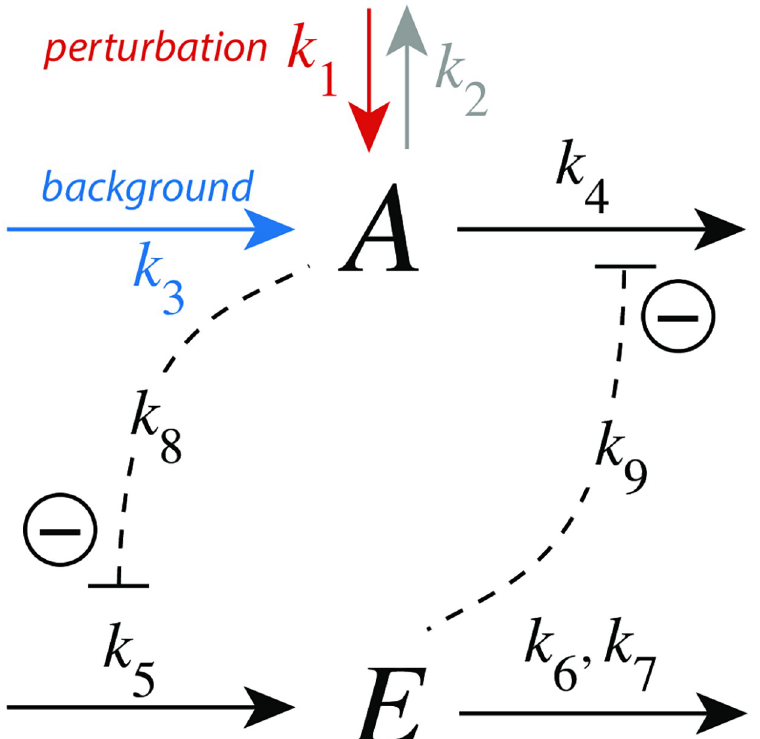
Fig 10. Outflow controller motif m8 with integral control implemented as a zero-order Michaelis-Menten (MM) type degradation of E. Rate constant k 1 undergoes a perturbation, while k 3 is a background inflow rate. k 8 and k 9 are inhibition constants. k 6 and k 7 are MM parameters analogous to V max and K M , respectively. For simplicity, the grayed- out rate constant k 2 is set to zero.